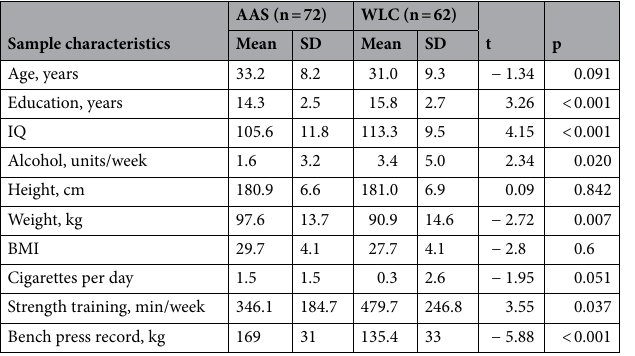
Table 2. Demographic and clinical data. Male weightlifters who used AAS (n = 72) were compared to a group of weightlifters who had not used AAS (n = 62). Data are number of participants and mean values (SD) for all variables. AAS: anabolic androgenic steroid, WLC: weightlifting control subjects, IQ: intelligence quotient, BMI: body mass